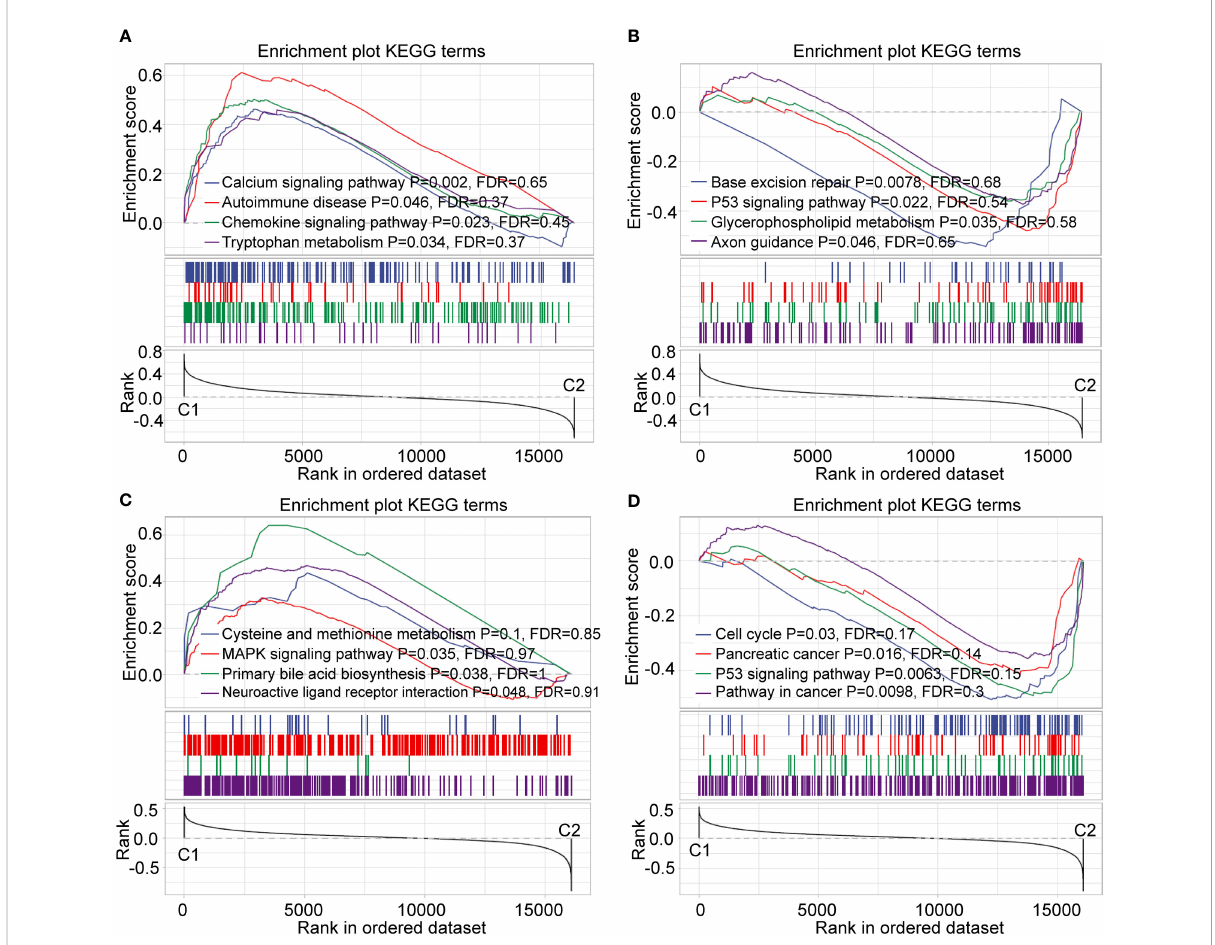
FIGURE 6 Enrichment analysis of GSEA pathway. (A, B) GSEA of C1 and C2 subtype in RNA-seq dataset. (C, D) GSEA of C1 and C2 subtype in the GEO